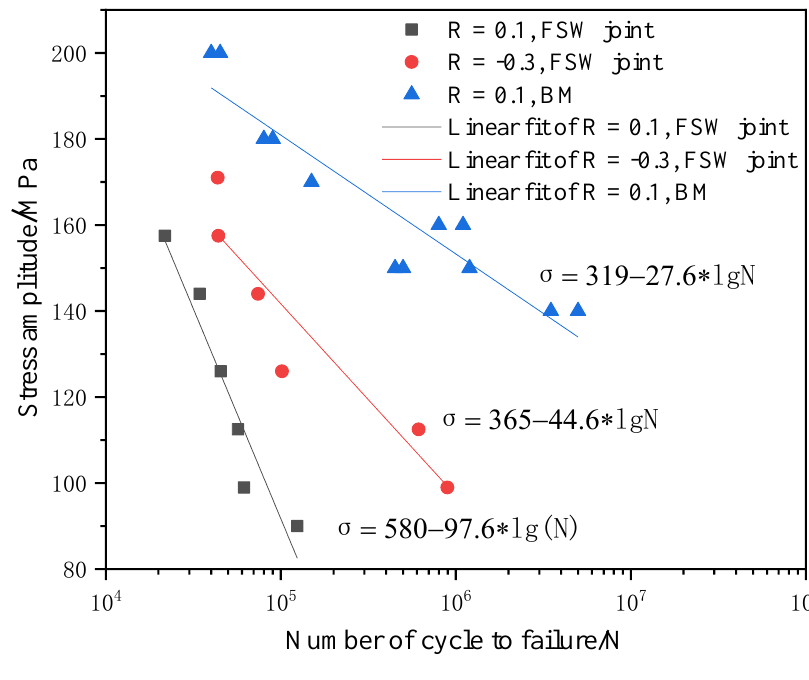
Figure 9. S-N curves of the FSW joint.